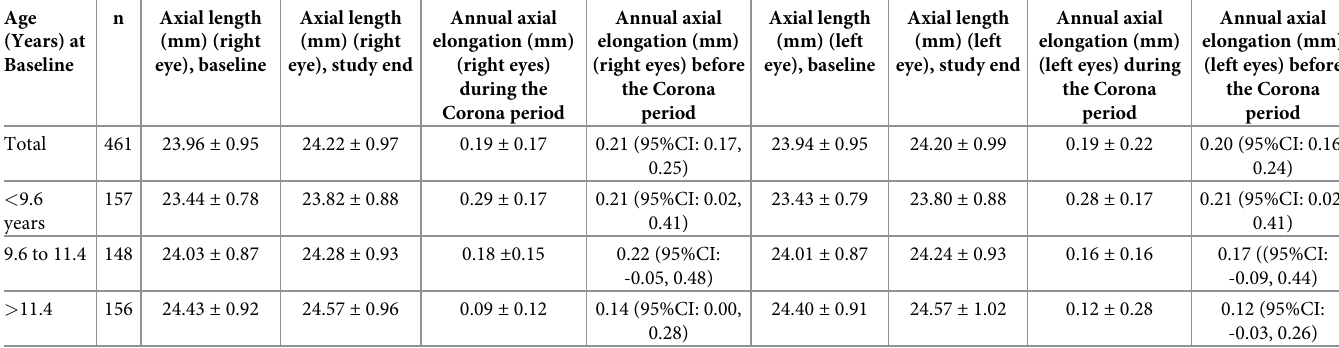
Fig 2. Scattergram showing the distribution of axial length in the right eyes at study end, stratified by age in the Ural Children Eye Study. Equation of the regression line: Axial Length (mm) = 22.34 mm + 0.16 (95%CI: 0.12, 0.20) x Age (Years). https://doi.org/10.1371/journal.pone.0279020.g002 error of the right eyes increased marginally significantly with older age at baseline ( P = 0.01; r 2 = 0.01) (equation of the regression line, right eyes: Refractive Error (D) = -0.63 + 0.05 (95%CI: 0.01, 0.09) x Age (Years), while the change in refractive error during the study period in the left eyes was not significantly associated with ag eat baseline (P = 0.07; r 2 = 0.01). Comparison of the ADCAL at baseline and the annual axial elongation during the study period in the total study population, the annual axial elongation during the study period was similar or slightly smaller than the ADCAL before the COVID-19 outbreak (0.19 mm (95%CI: -0.09, 0.59) versus 0.21 mm (95%CI: 0.17, 0.25) for the right eyes; 0.19 mm (95%CI: -0.09, 0.58) versus 0.20 mm (95%CI: 0.16, 0.24) for the left eyes) (Table 1). To analyze a potential effect of the lockdown on axial length in dependence of age, we divided the study population into three, mostly equally sized groups. In the group of study par- ticipants younger than 9.6 years (n = 157 children), annual axial elongation in the right eyes Table 1. Axial length (mean ± standard deviation) in the Ufa Children Myopia